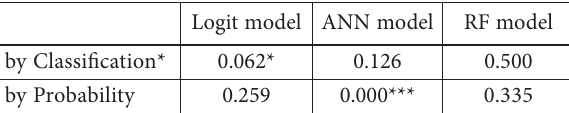
Table 7. Mann-Whitney test results between the original and polynomial models